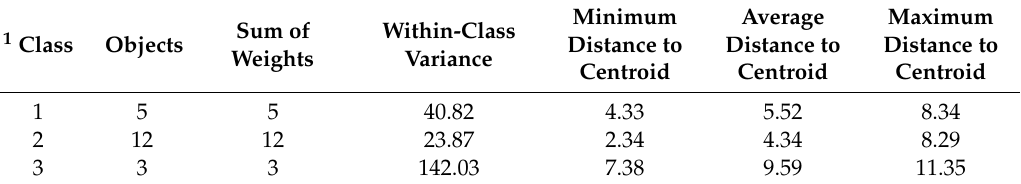
Table 6. Results by class through k-means clustering.